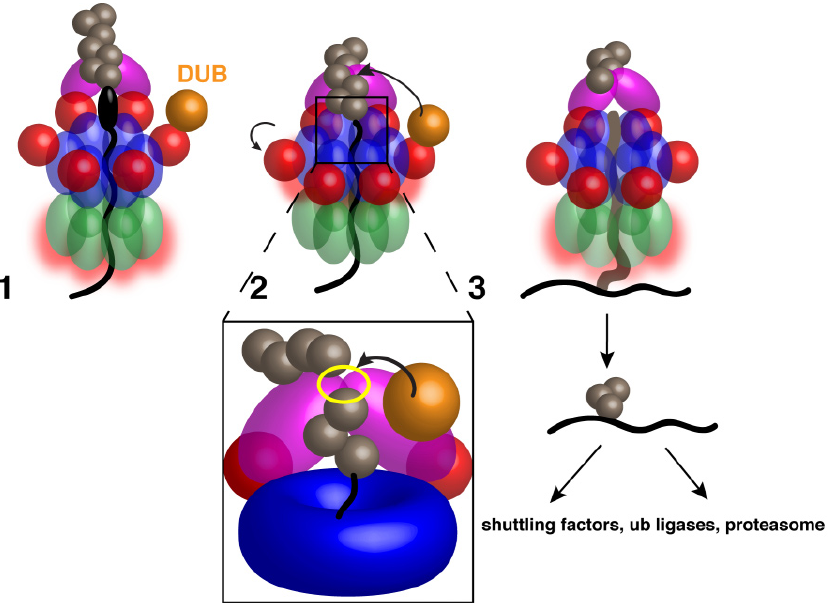
Figure 3. Model for substrate release from Cdc48. Stage 1: The substrate is pulled through the double-ring ATPase, but the polyubiquitin chain is bound to the Ufd1/Npl4 (UN) complex at the cis side, preventing full substrate translocation through the pore, even with continued D2 ATP hydrolysis. A deubiquitinase (DUB) bound to the N domain cannot access the polyubiquitin chain while D1 is in the ATP-bound state and the N domains are in the “up conformation”. Stage 2: D1 hydrolyzes ATP after the substrate has initiated or completed translocation, moving the N domains into the “down conformation” and allowing DUB access to the ubiquitin chain. Inset: The likely Ub chain cleavage site is between the UN binding site (yellow outline) and the central pore; any Ub moieties proximal to the cleavage site will be translocated.